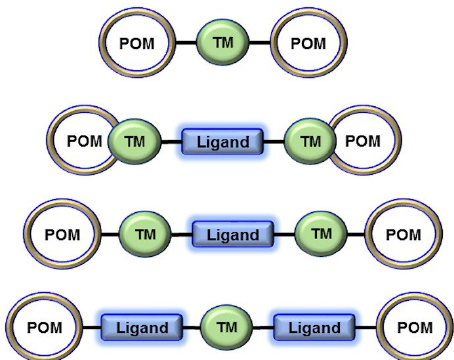
Figure 8. The four types of POM–Ligand connectivities.